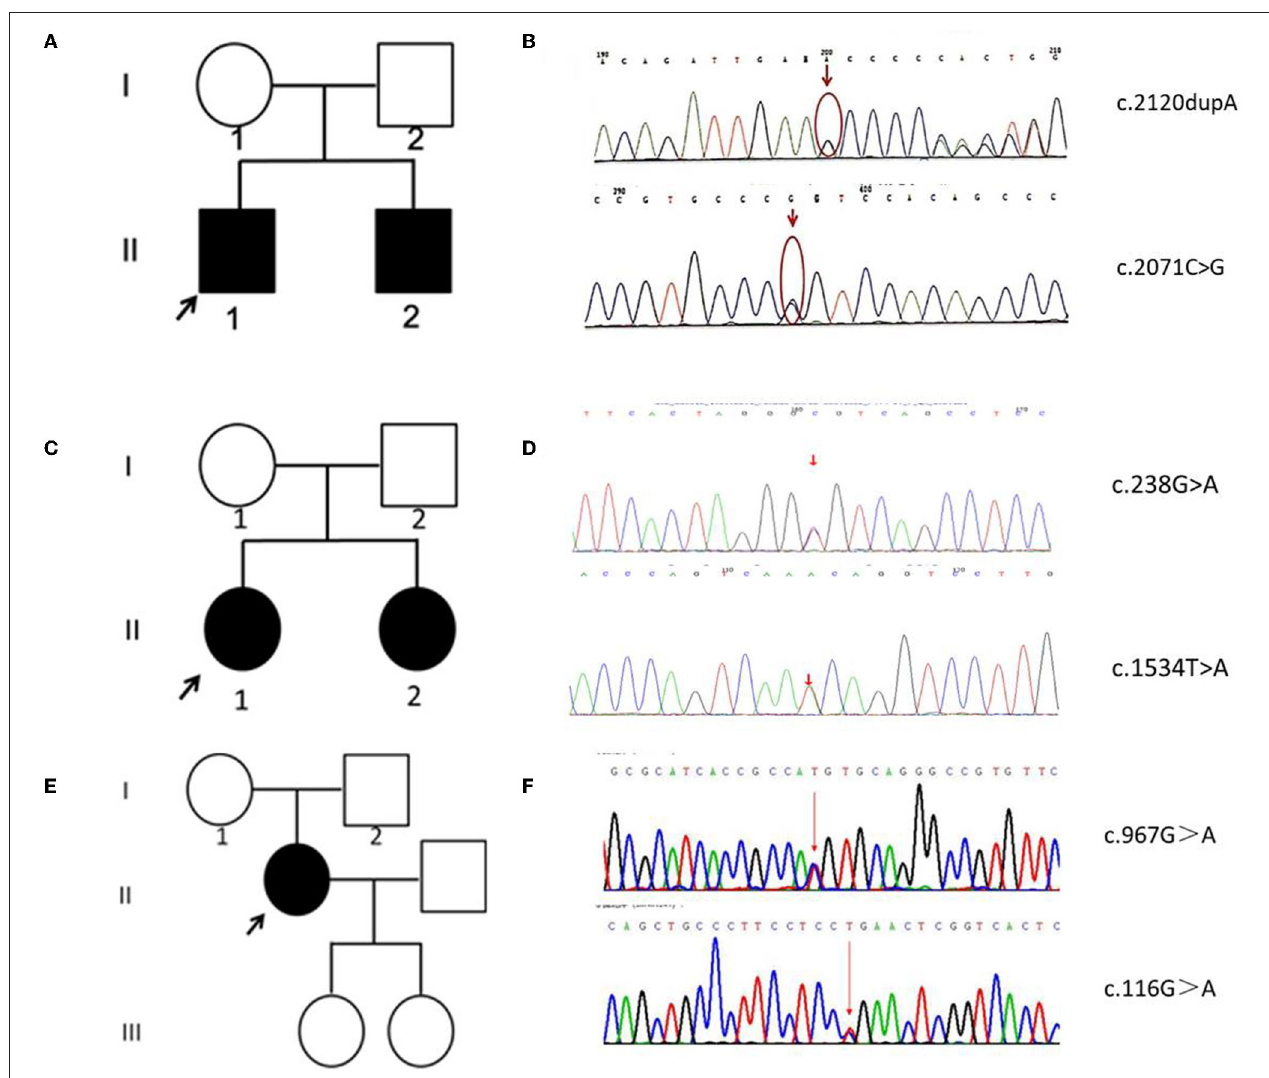
FIGURE 2 | Family pedigrees and Sanger sequencing data of five patients. (A) The pedigree chart of family A. (B) The Sanger sequence chromatogram of family A. (C) The pedigree chart of family B. (D) The Sanger sequence chromatogram of family B. (E) The pedigree chart of family C. (F) The Sanger sequence chromatogram of family C. Open symbol: unaffected; filled symbol: affected; black arrows: proband. Red arrows: mutation